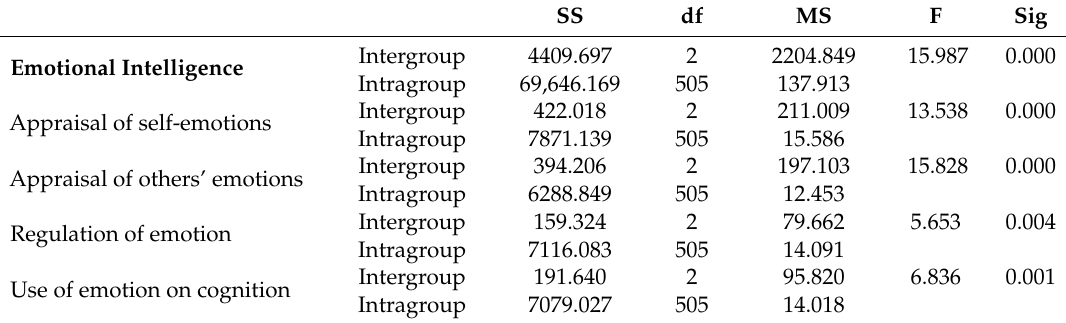
Table 9. Grade di ff erences in emotional